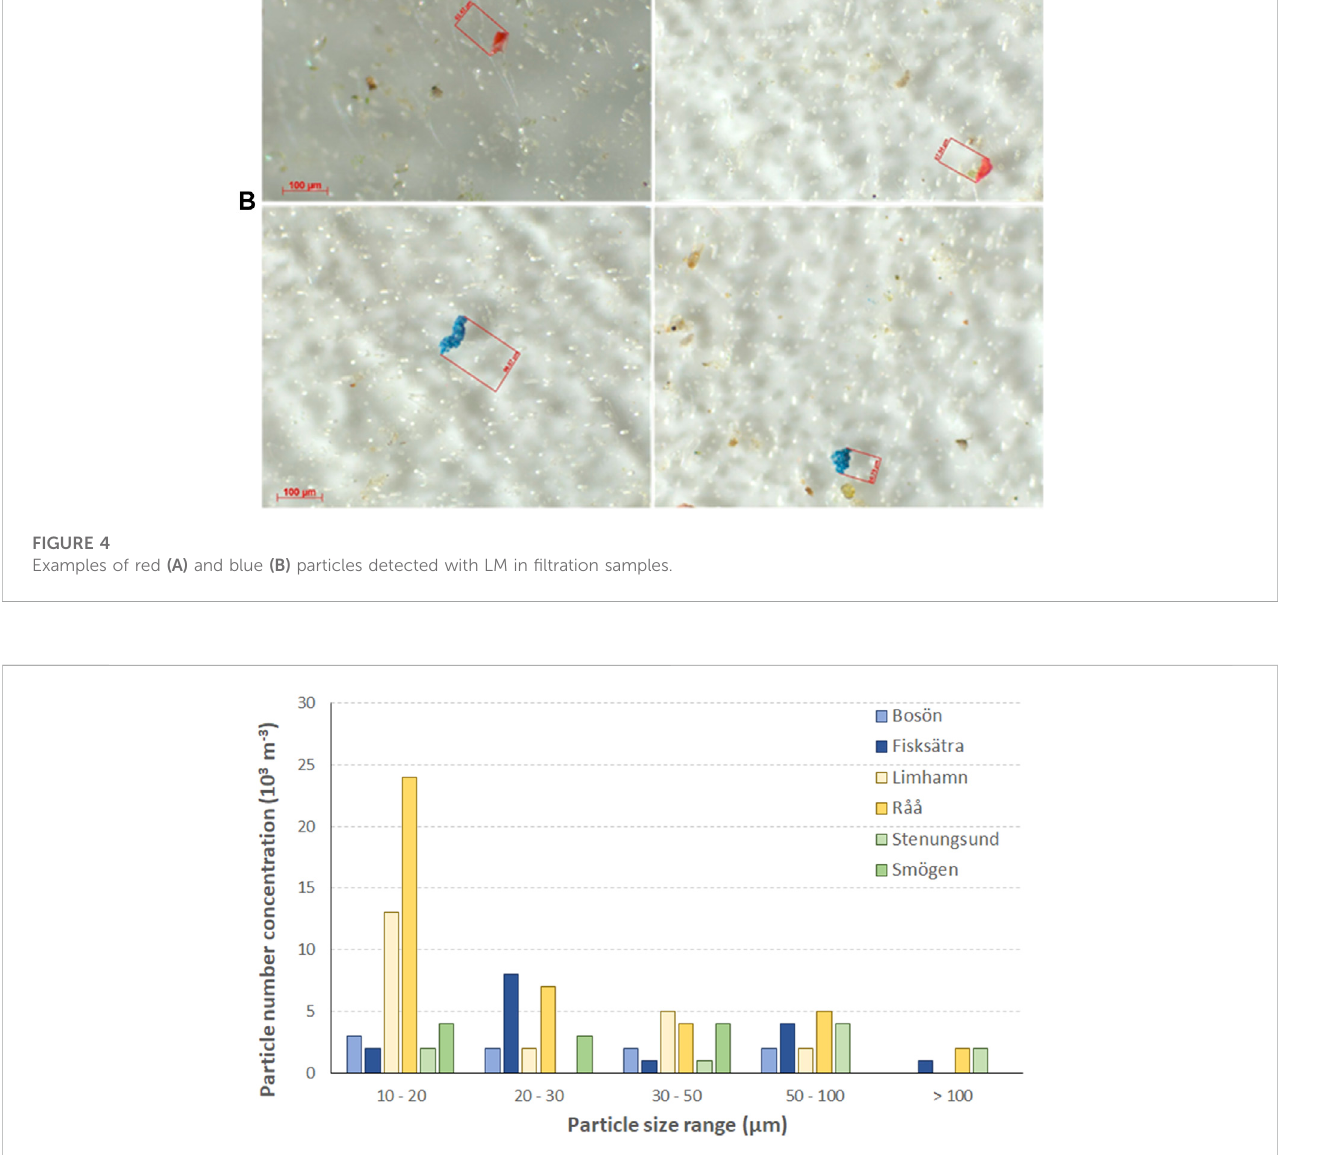
FIGURE 5 Size distribution of particles collected with Ruttner sampler, fi ltered (10 µm), and detected with automated LM